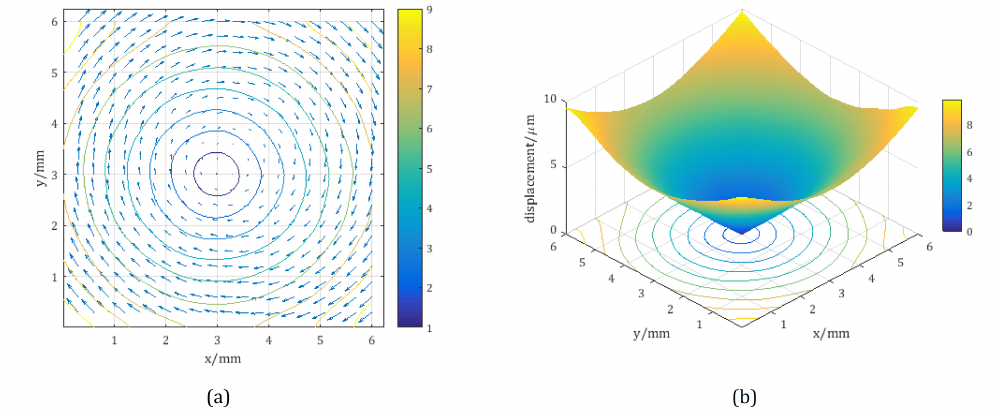
Figure 7. ( a ) synthetic in-plane displacements vectors of l x and l y ; ( b ) absolute value of the displacement | d | in µ